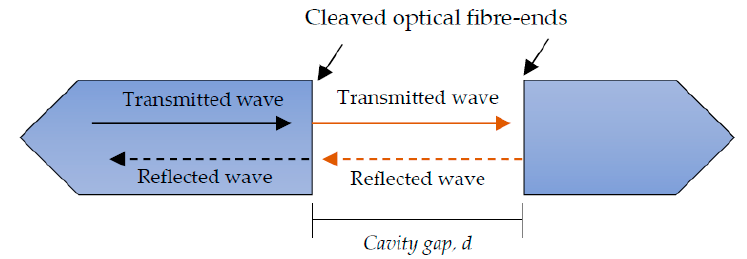
Figure 6. The principle of a Fabry-Perot sensor.